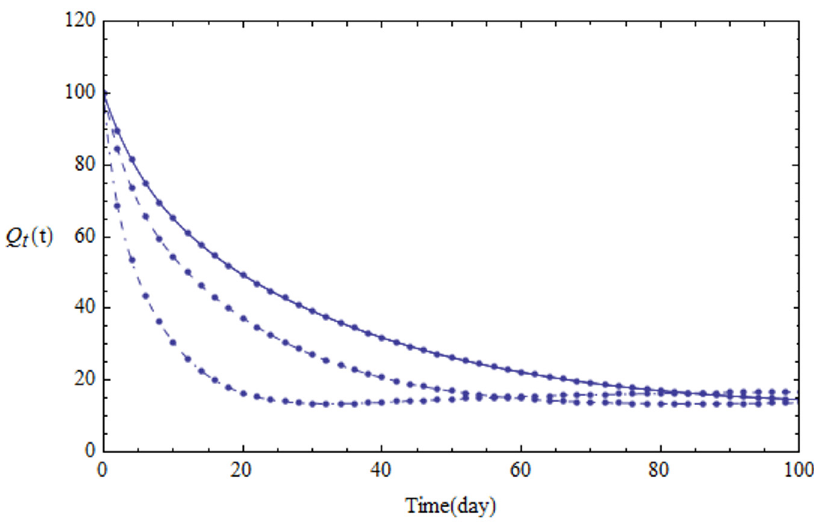
Fig 4. The population of Q t ( t ) versus t: α = 1.0 (solid line), α = 0.95 (dashed line) and α = 0.85 (dot- dashed line).